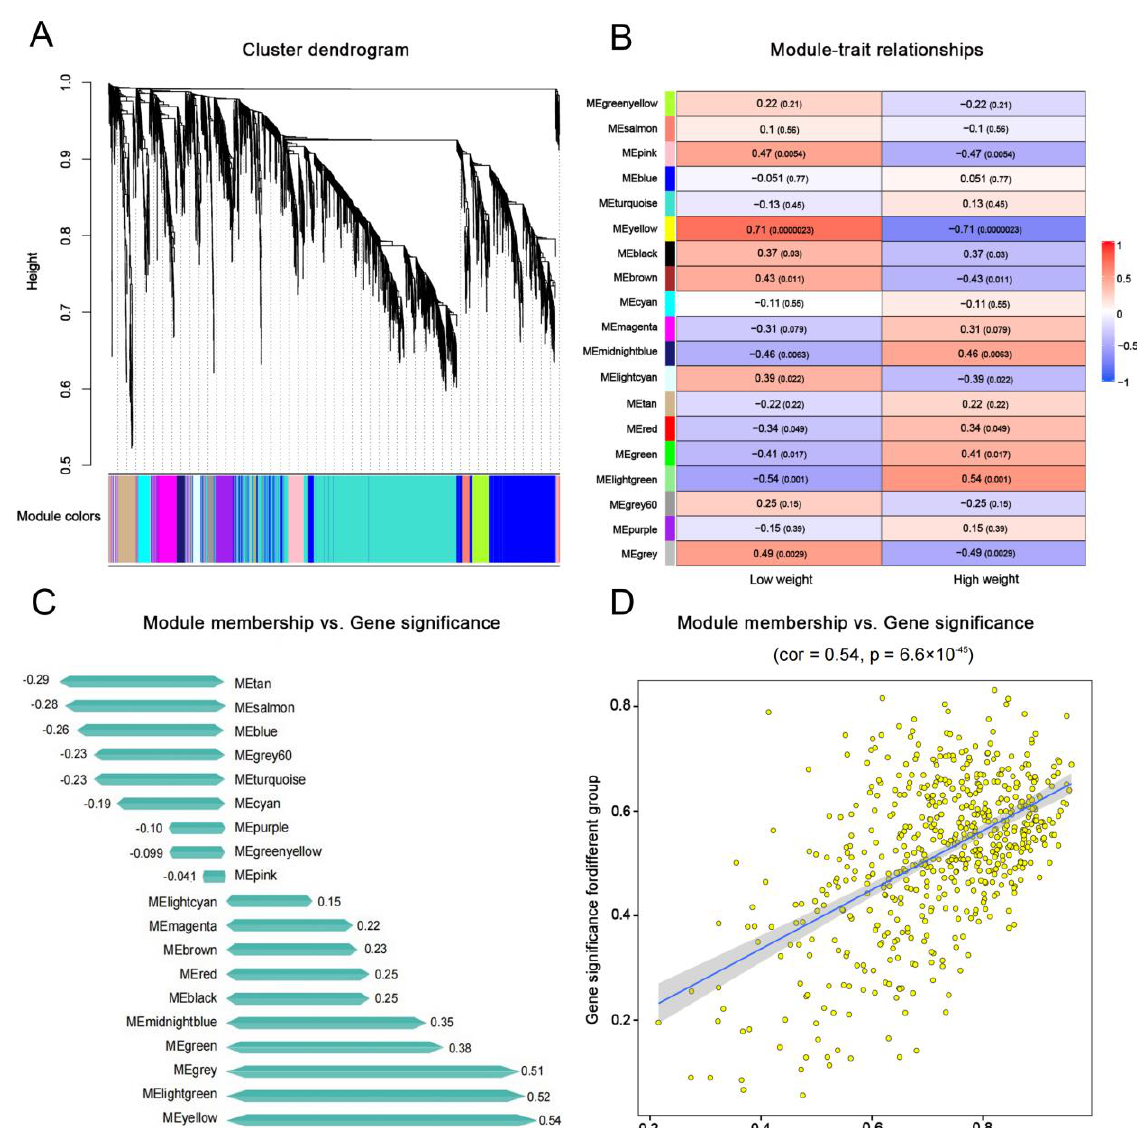
Figure 1. Co-expressed gene modules detected by weighted gene co-expression network analysis (WGCNA). ( A ) Cluster dendrogram showing the co-expression modules defined by WGCNA and labeled by colors. ( B ) Module-trait relationships showing the correlation between gene module and sample information, where the x -axis represents sample information, and the y -axis represents each gene module. In the panel, the darker the color, the higher the correlation, with red representing positive correlation and blue representing negative correlation. Significance values expressed as p -values are in parentheses. ( C ) Module membership and gene significance relationships of each module. ( D ) Scatterplot of Gene Significance (GS) for body type vs. Module Membership (MM) in yellow